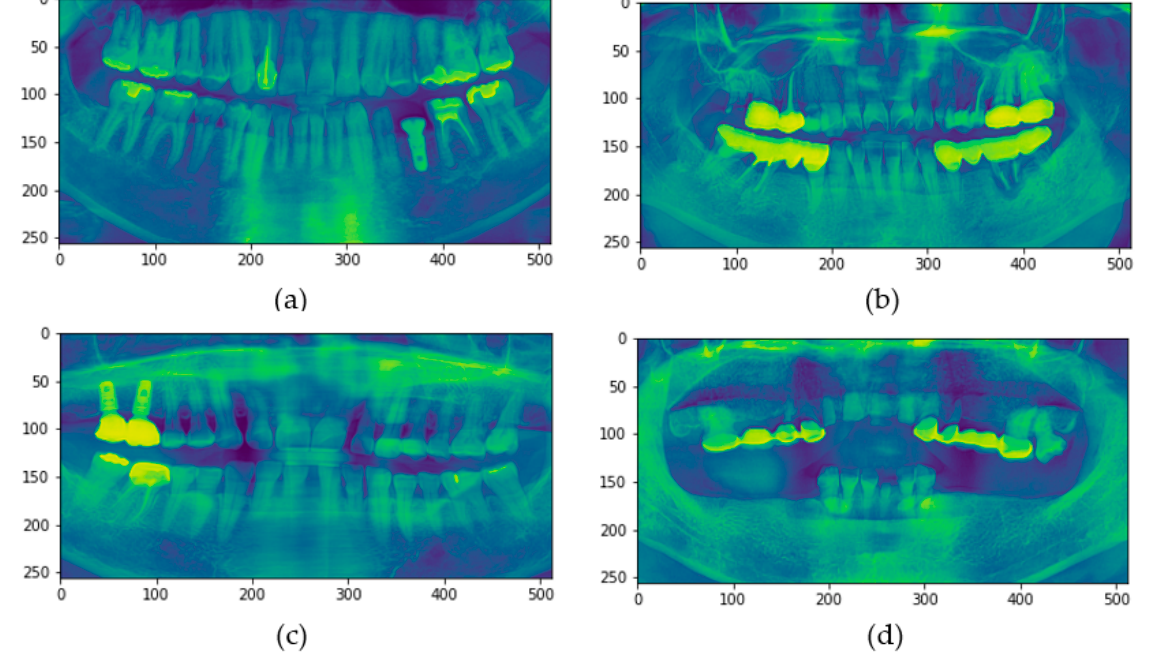
Figure 10. Dental radiographs of persons whose dental ages were misclassified by more than 15 years: ( a ) actual age is in the 50s, predicted dental age is 38.31; ( b ) actual age is in the 30s, predicted dental age is 55.07; ( c ) actual age is in the 70s, predicted dental age is 59.41; and ( d ) actual age is in the 30s, predicted dental age is 70.09.